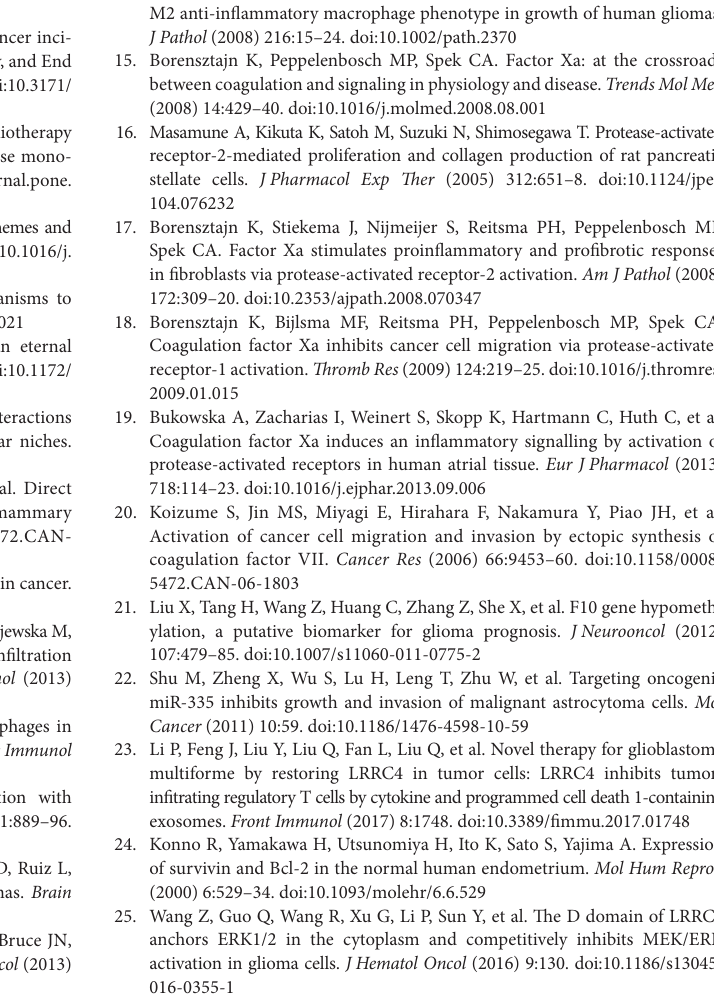
FigUre s1 | Factor X (FX) influenced tumor growth in vivo but not in vitro. (a) Confocal microscopy showed GFP-FX localized to the trans-Golgi network and vesicles. (B) FX expression was increased in GL261-FX cells shown by Western blotting. (c) The viability of GL261-CON and GL261-FX was measured by XTT assays. FigUre s2 | Factor X (FX) interacted with extracellular signal-related kinase (ERK)1/2 and influenced p-ERK1/2 and p-AKT. (a) FX was speculated to interact with ERK1/2 predicted by Scansite 3.0. (B) The interaction of FX and AKT was measured by co-immunoprecipitation. FigUre s3 | CASC2c and miR-338-3p regulated factor X (FX) expression. (a) FX was speculated to be a target of miR-338-3p by TargetScan (http://www. targetscan.org). (B) CASC2c was speculated to interact with miR-338-3p by miRcode (http://www.mircode.org). (c) Nucleotide resolution of miRNA-binding sites in FX and miR-338-3p. (D) Nucleotide sequence of miRNA-binding sites in CASC2c and